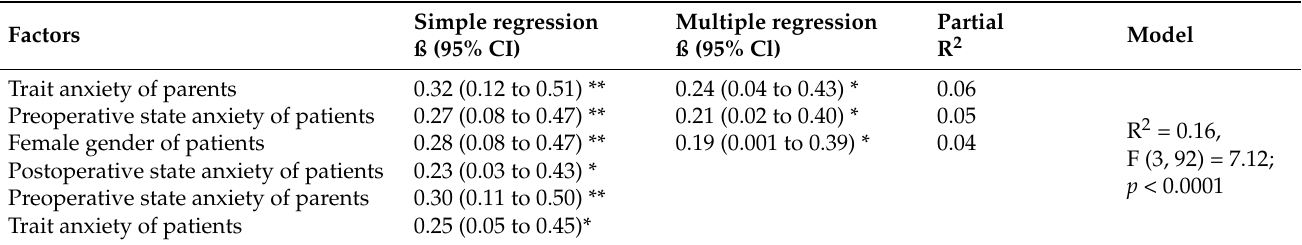
Table 6. Multiple linear regression analysis for variables predicting postoperative parental anxiety.